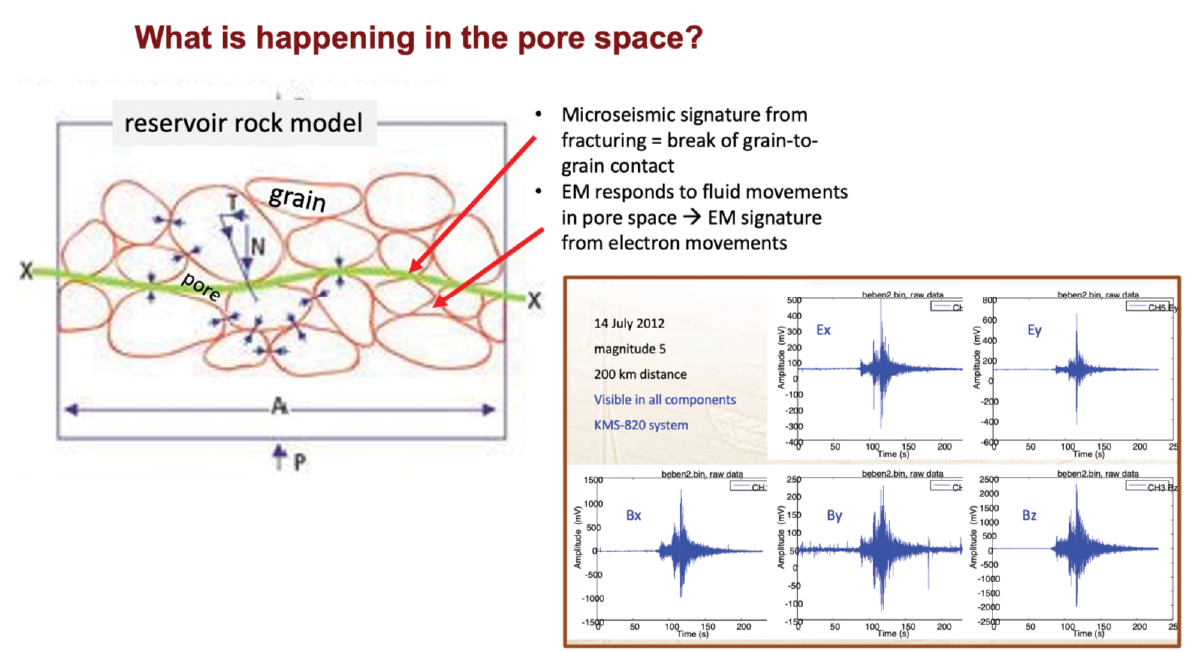
Figure 3. Pore space model based on Carlson [14] showing grains building the rock skeleton and pore space. The fluids are in the pore space, and the reservoir boundaries are defined by grain-to-grain contact indicated by the green line. When a grain-to-grain contact breaks, a seismic signal is sent. Before that, the stress and strain on the pore fluid causes mobility and this causes electrons to move dramatically, reducing the resistivity of the pore fluid and thus the bulk resistivity. On the right of the figure is an example of an EM signal from an earthquake in India as recording on all 5 components of an EM system.